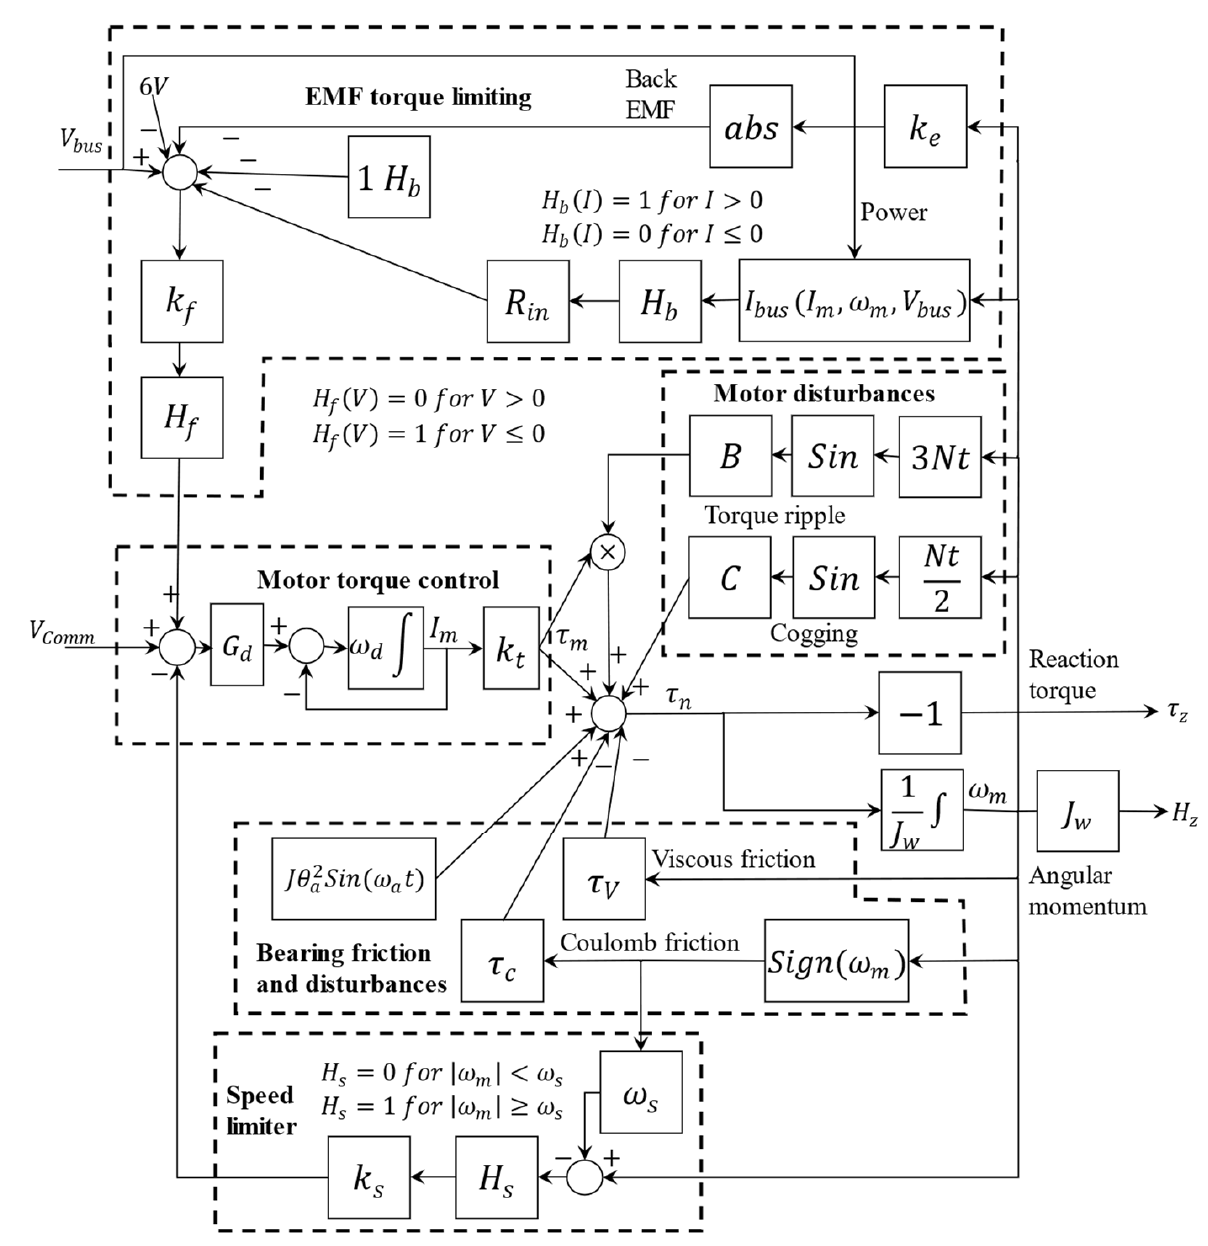
Figure 3. High-fidelity RW dynamic adapted from [25] where k t feeds to multiplication term in Bsin ( 3 Nt ) and uses a low-pass filter in the motor torque control block.